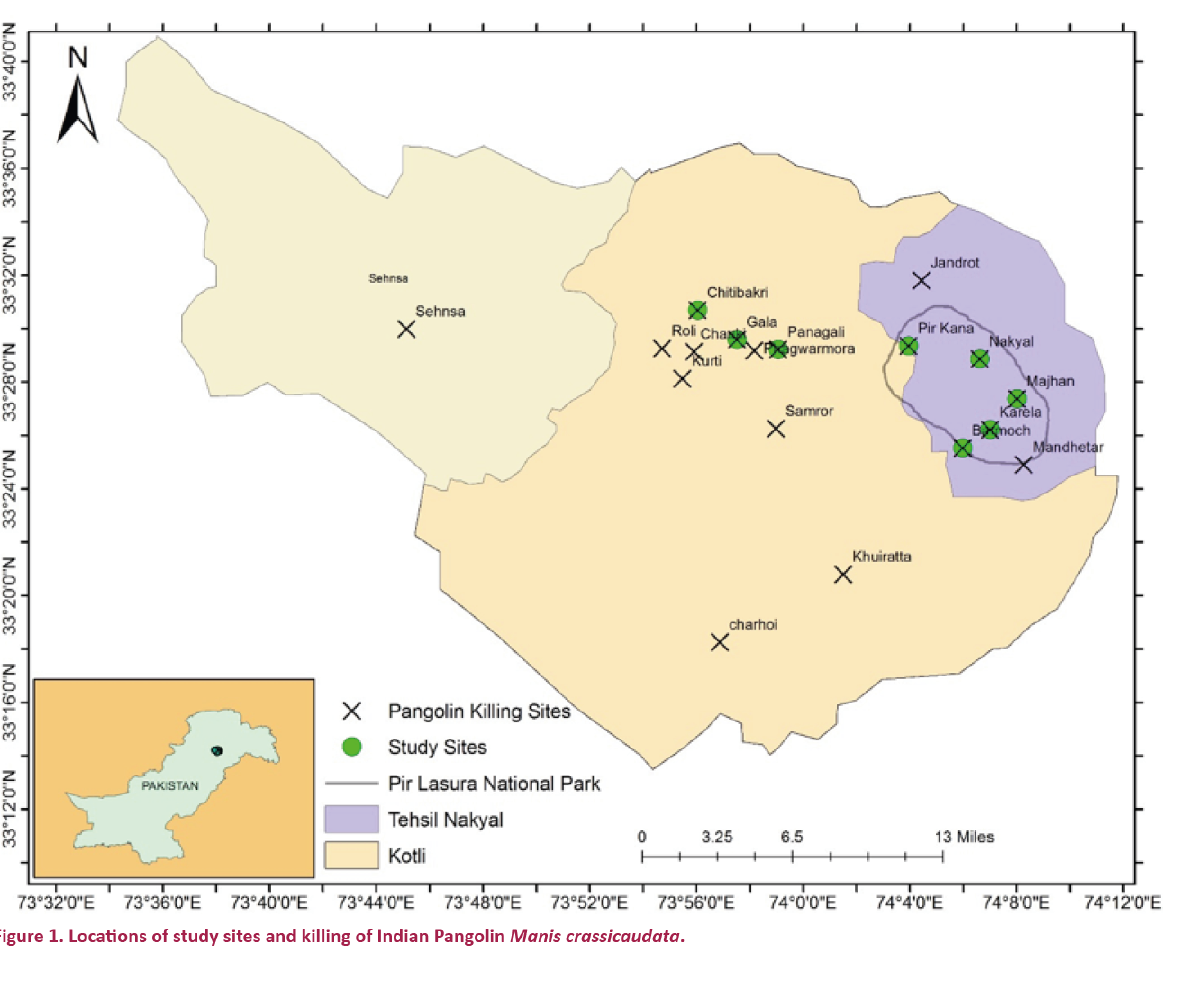
Ffigure 1. Locafions of sttudy sfittes and kfillfing of Indfian Pangolfin Manfis crassficaudatta.